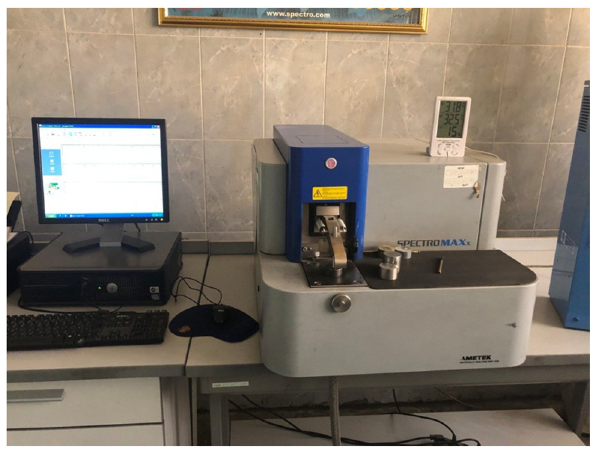
Figure 1: Thermo ARL 3460 optical emission spectrometer.